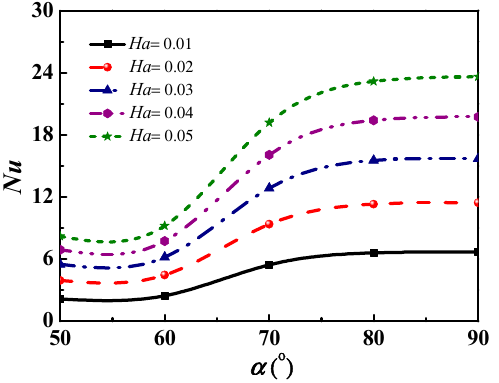
Figure 7. The Nu number varies with the magnetic direction in microchannels with an aspect ratio 3:1.